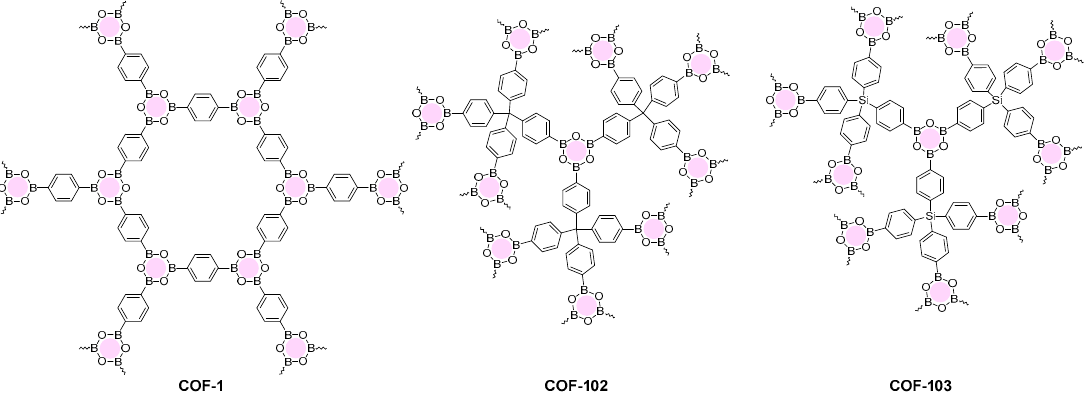
Figure 2. Chemical structures of classic boron-containing COFs (COF-1, COF-102, COF-103) with boroxine connections.